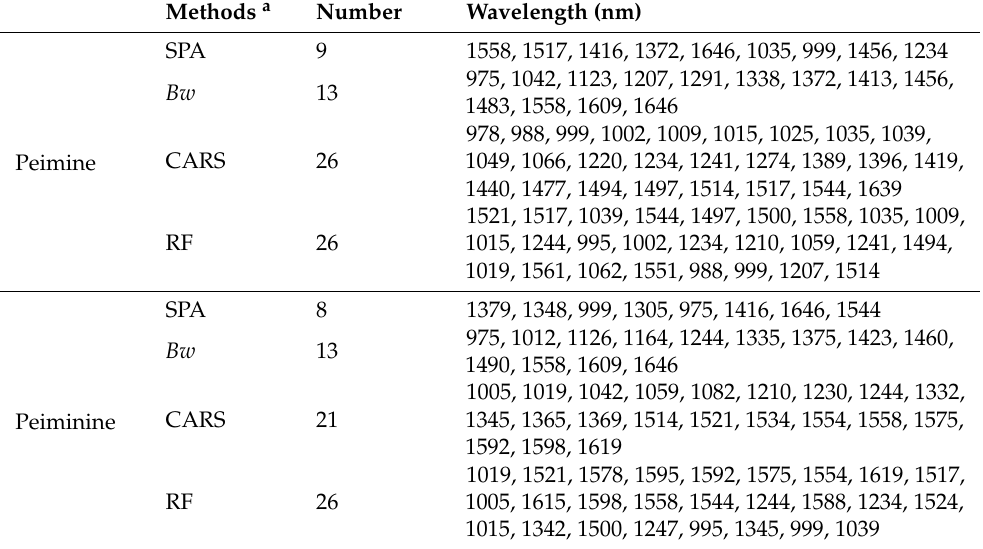
Table 2. Optimal wavelengths selected for peimine and peiminine content prediction by SPA, Bw , CARS, and